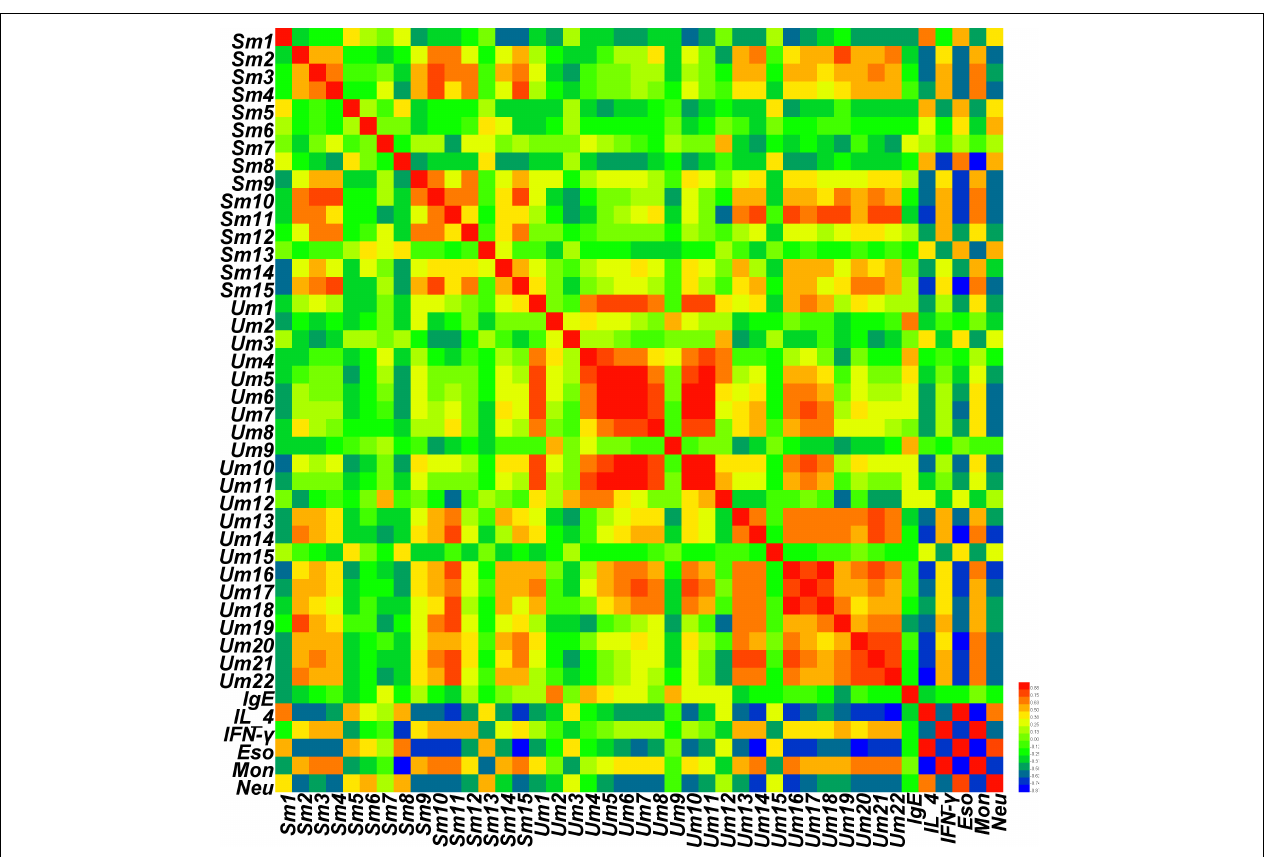
FIGURE 8 | Correlation map of rat serum and urine metabolites and pharmacodynamics indices according to Pearson correlation coefficients. Degrees of correlation degrees are shown using a color scale from significantly negatively correlated (blue) to significantly positively correlated